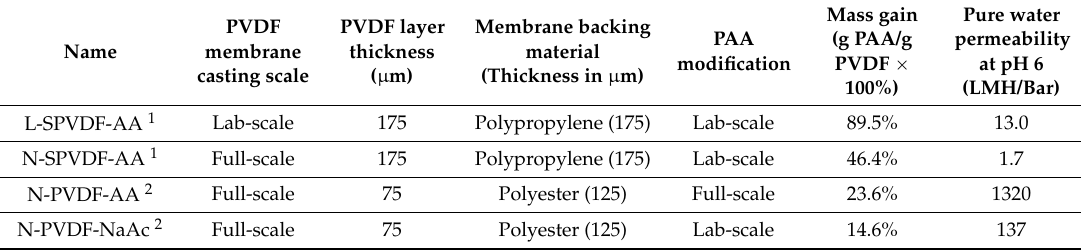
Figure 2. SEM images of non-spongy membrane (N-PVDF) cross-section ( A ); lab-scale spongy membrane L-SPVDF cross-section ( B ); and full-scale spongy membrane N-SPVDF cross-section before polyacrylic acid (PAA) functionalization ( C ); and N-SPVDF after PAA functionalization ( D ). Table 1. Functionalized membrane synthesis conditions and physical properties.